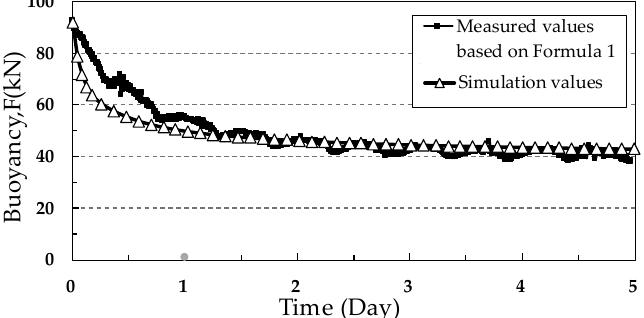
Figure 10. Comparison of buoyancy between numerical analysis and field test.